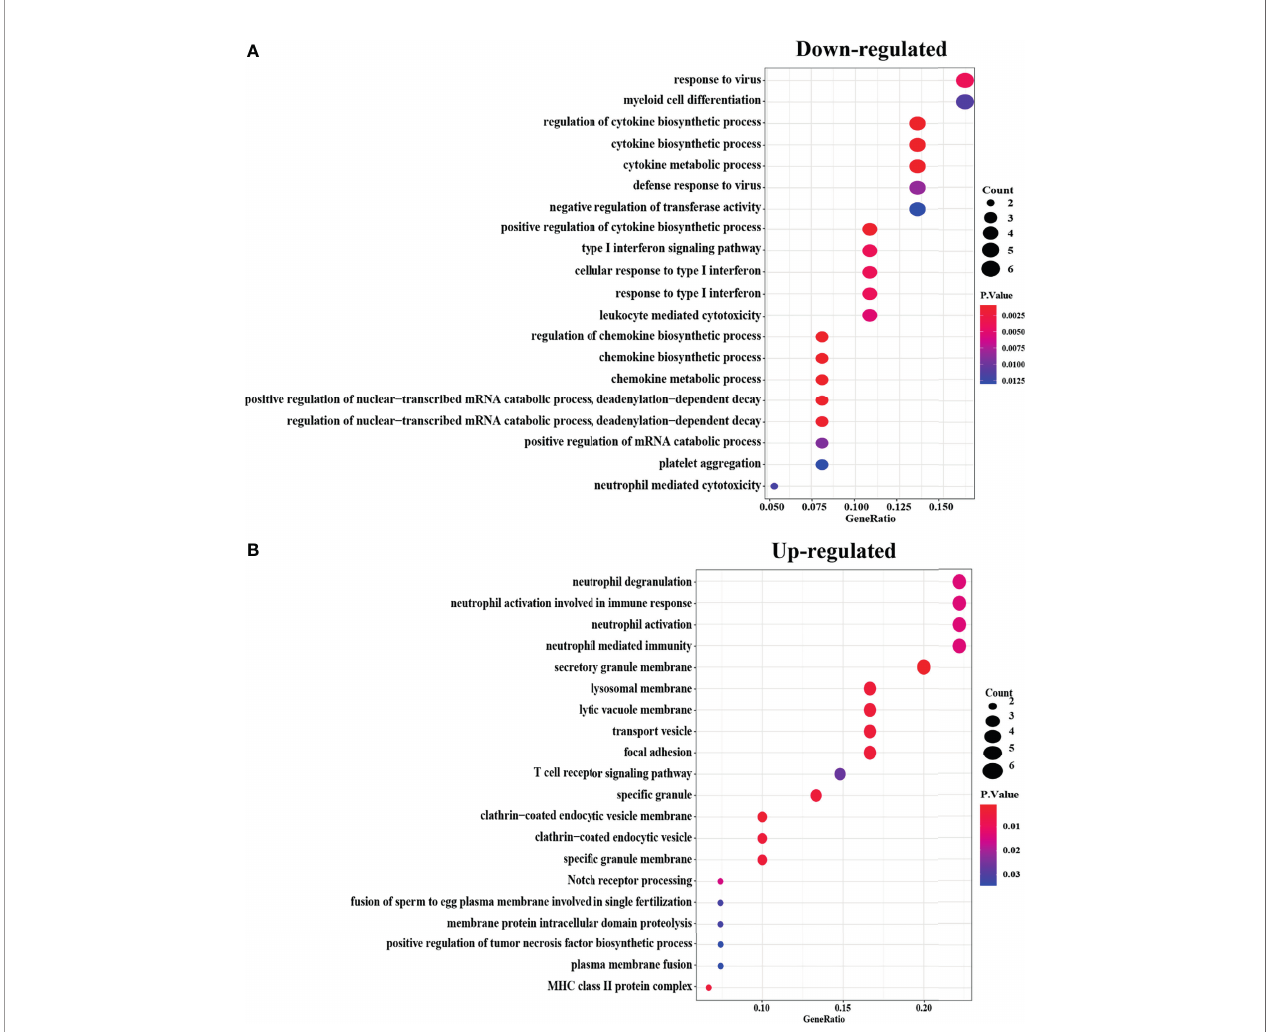
FIGURE 2 | GO enrichment of Robust DEGs with the cut off criteria of P-Value <0.05. The bubble color represents P-Value in enriched pathways, and the size of the bubble represents the gene number. (A) Downregulated Robust DEGs in three parts of GO enrichment (BP, CC, and MF). (B) Upregulated Robust DEGs in three parts of GO enrichment (BP, CC, and MF). DEG, differentially expressed gene; GO, Gene Ontology; BP, biological process; CC, cellular component; MF, molecular function.